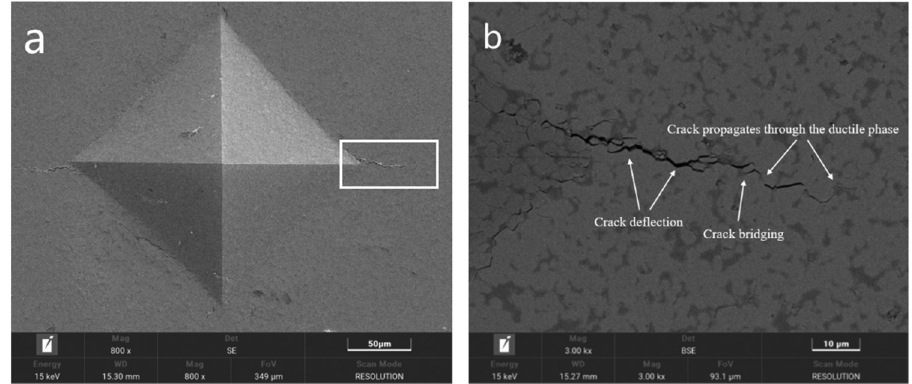
Figure 11: Indentation crack of 1,390°C sintered NbC – 12Ni cermets: ( a ) exemplary indentation and ( b ) crack